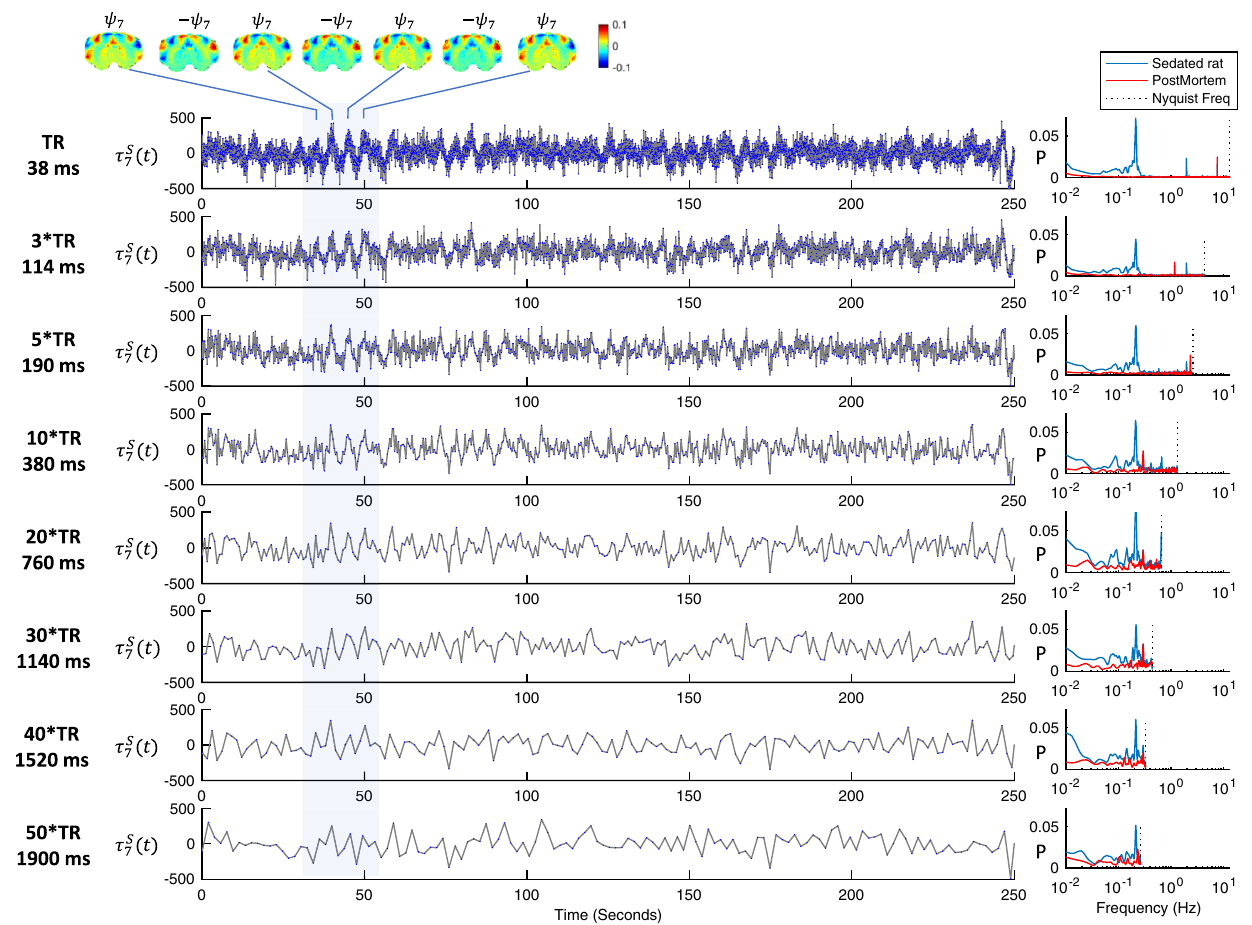
Fig. 5 | Effect of the sampling rate in the power spectrum given a fi xed scan duration. Left: The un fi ltered temporal signal τ S 7 ð t Þ associated with the 7th prin- cipal component detected in ultrafast fMRI signals from medetomidine-sedated rats(Time of Repetition, TR=38milliseconds, ms) is downsampledby considering only one in every 3, 5, 10, 20, 30, 40 and 50 frames (corresponding to intervals of 114, 190, 380, 760, 1140, 1520 and 1900ms between frames). Plots are shown for